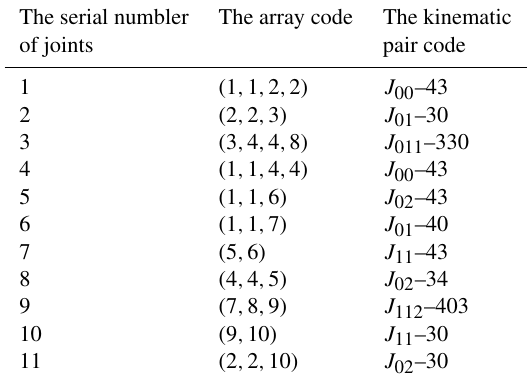
Table 2. The kinematic pair